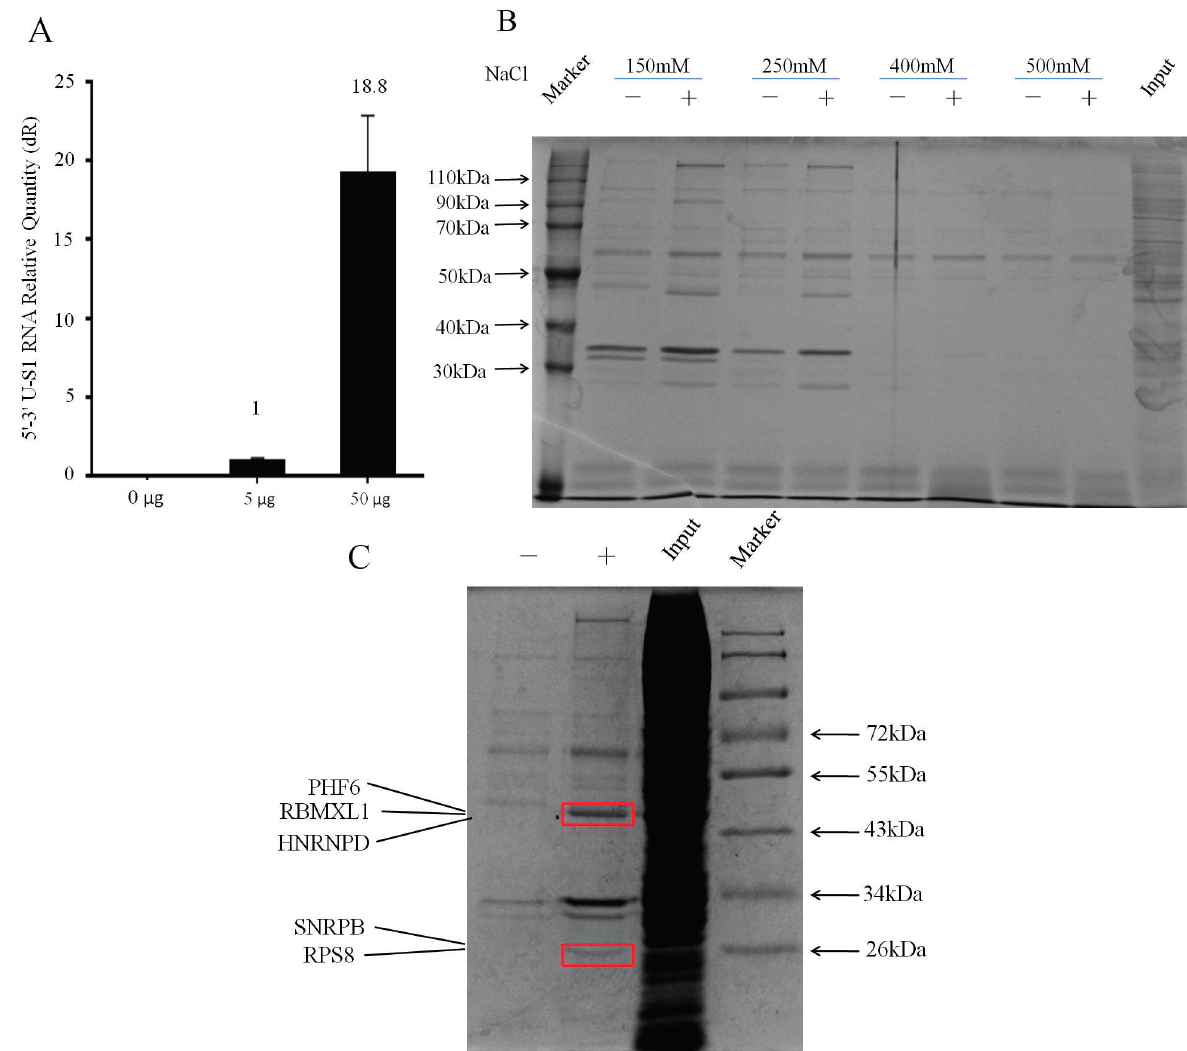
Figure 2. Purification of endogenously-assembled 5 ′ –3 ′ U-S1 RNPs. ( A ) The 5 ′ –3 ′ U-S1RNAs eluted from streptavidin beads were detected by RT-qPCR with different amount of plasmid shown. In order to normalize the RT-qPCR, an equal amount of β -actin RNA was added to both groups prior to isolating RNA from beads; ( B ) In the RNA pull down assay, the wash buffer containing different NaCl concentrations was applied to explore the perfect wash conditions for affinity purification. Proteins bound to washed streptavidin beads from 5 ′ –3 ′ U-S1 RNA and mock purifications were resolved by SDS-PAGE and visualized by Coomassie blue staining. Lanes marked with a minus are untransfected controls; ( C ) The two distinguished gel bands of the 5 ′ –3 ′ U-S1 RNA purification compared to mock purification were subjected to mass spectrometry, and five proteins were